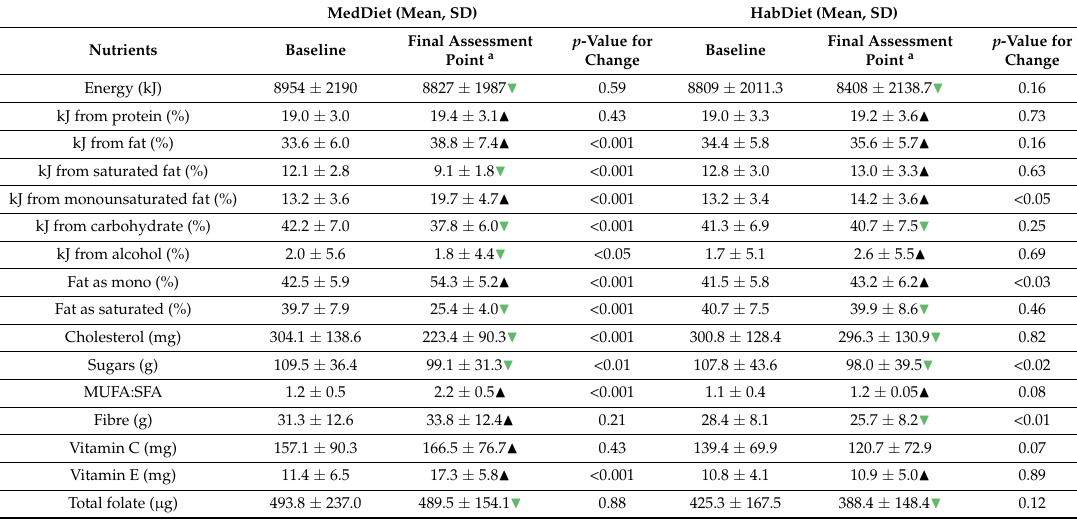
Table 2. Changes in nutrient intake from baseline to the final assessment point observed for the experimental MedDiet group and control HabDiet